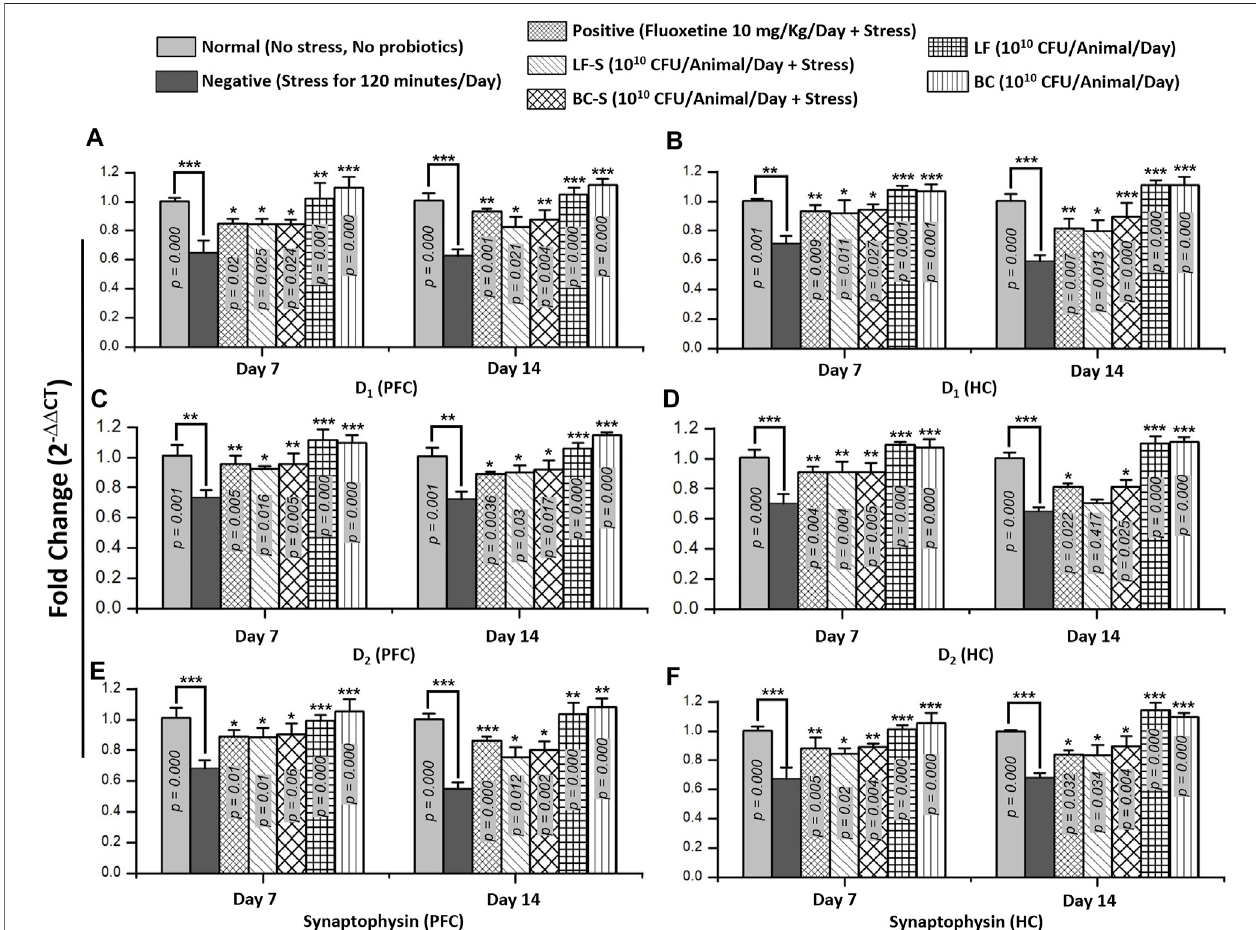
FIGURE6| Effectsof Lactobacillusfermentum NMCC-14 (10 10 CFU/day,p.o)and Bacillus clausii (10 10 CFU/day,p.o) onmRNAlevelsofdopamine receptors (D 1 and D 2 ) and synaptophysin in the prefrontal cortex and hippocampus of acute and subacute restraint-stressed and normal mice. Compared to the negative group, the mRNA expression of dopamine receptor subtypes (D 1 and D 2 ) and synaptophysin increased in the PFC (A,C,E) and HC (B,D,F) signi fi cantly ( n = 5/group) by acute and subacute administration of Lactobacillus fermentum NMCC-14 and Bacillus clausii in LF-S (except D 2 in the HC, day 14) and BC-S mice. Compared to the normal group,nosigni fi cant( p < 0.05)changewasobservedinthemRNAexpressionofdopaminereceptorsubtypes(D 1 andD 2 )andsynaptophysininthePFC (A,C,E) andHC (B,D,F) of BC and LF mice. Values expressed are mean ± standard error to the mean (SEM). Note that # p = 0.05, * p < 0.05, ** p < 0.01, and *** p < 0.001 versus the negative group by applying two-way ANOVA.